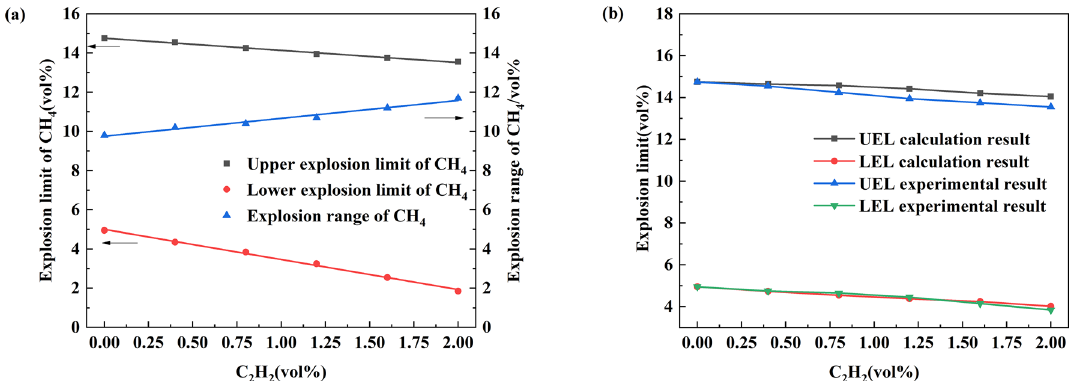
Figure 4. Explosion limit for methane in air [( a ) Methane explosion limit change, ( b ) comparison of calculated and experimental